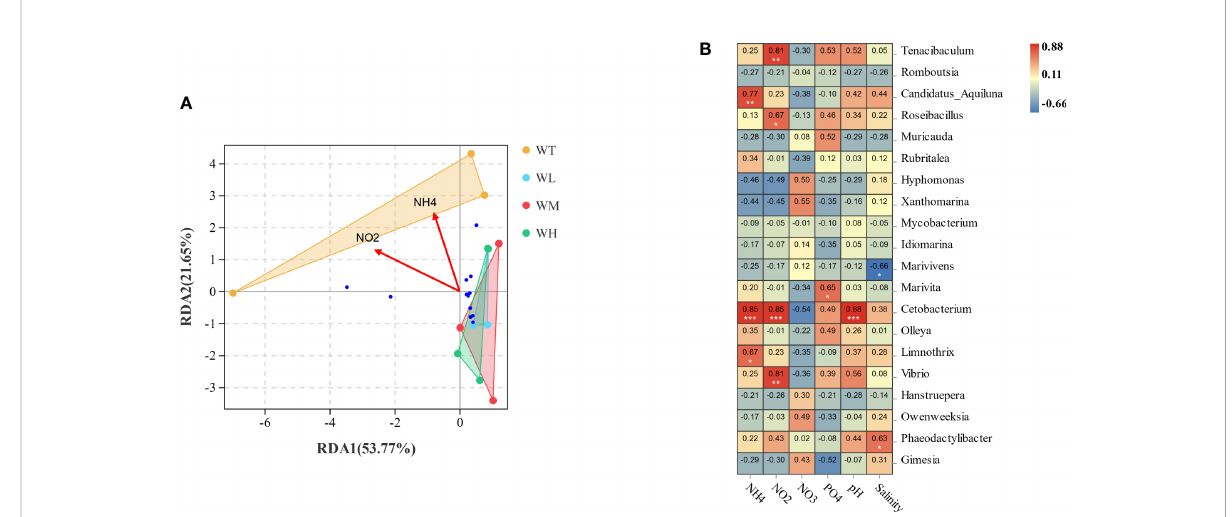
FIGURE 4 (A) Redundancy analysis (RDA) was used to produce a two-dimensional sorting map relating the culture water microbiota to the water quality indicators. (B) Pearson ’ s correlation heatmap analysis at the genus level. * p < 0.05; ** p < 0.01; *** p < 0.001.